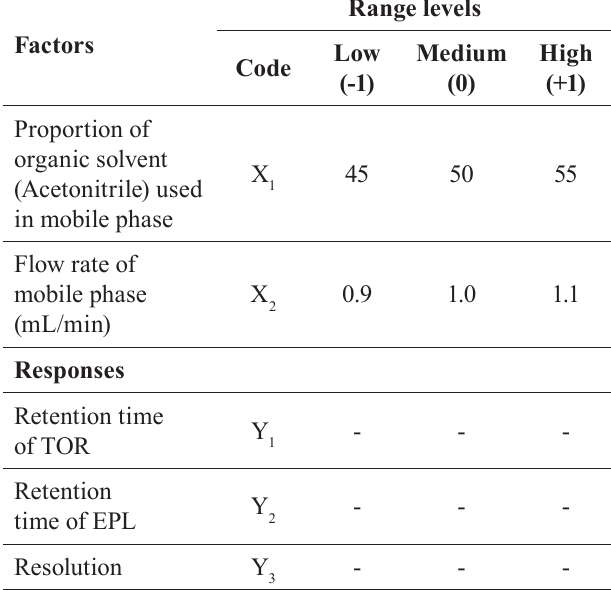
TABLE I - E xperimental plan of CCD showing factors